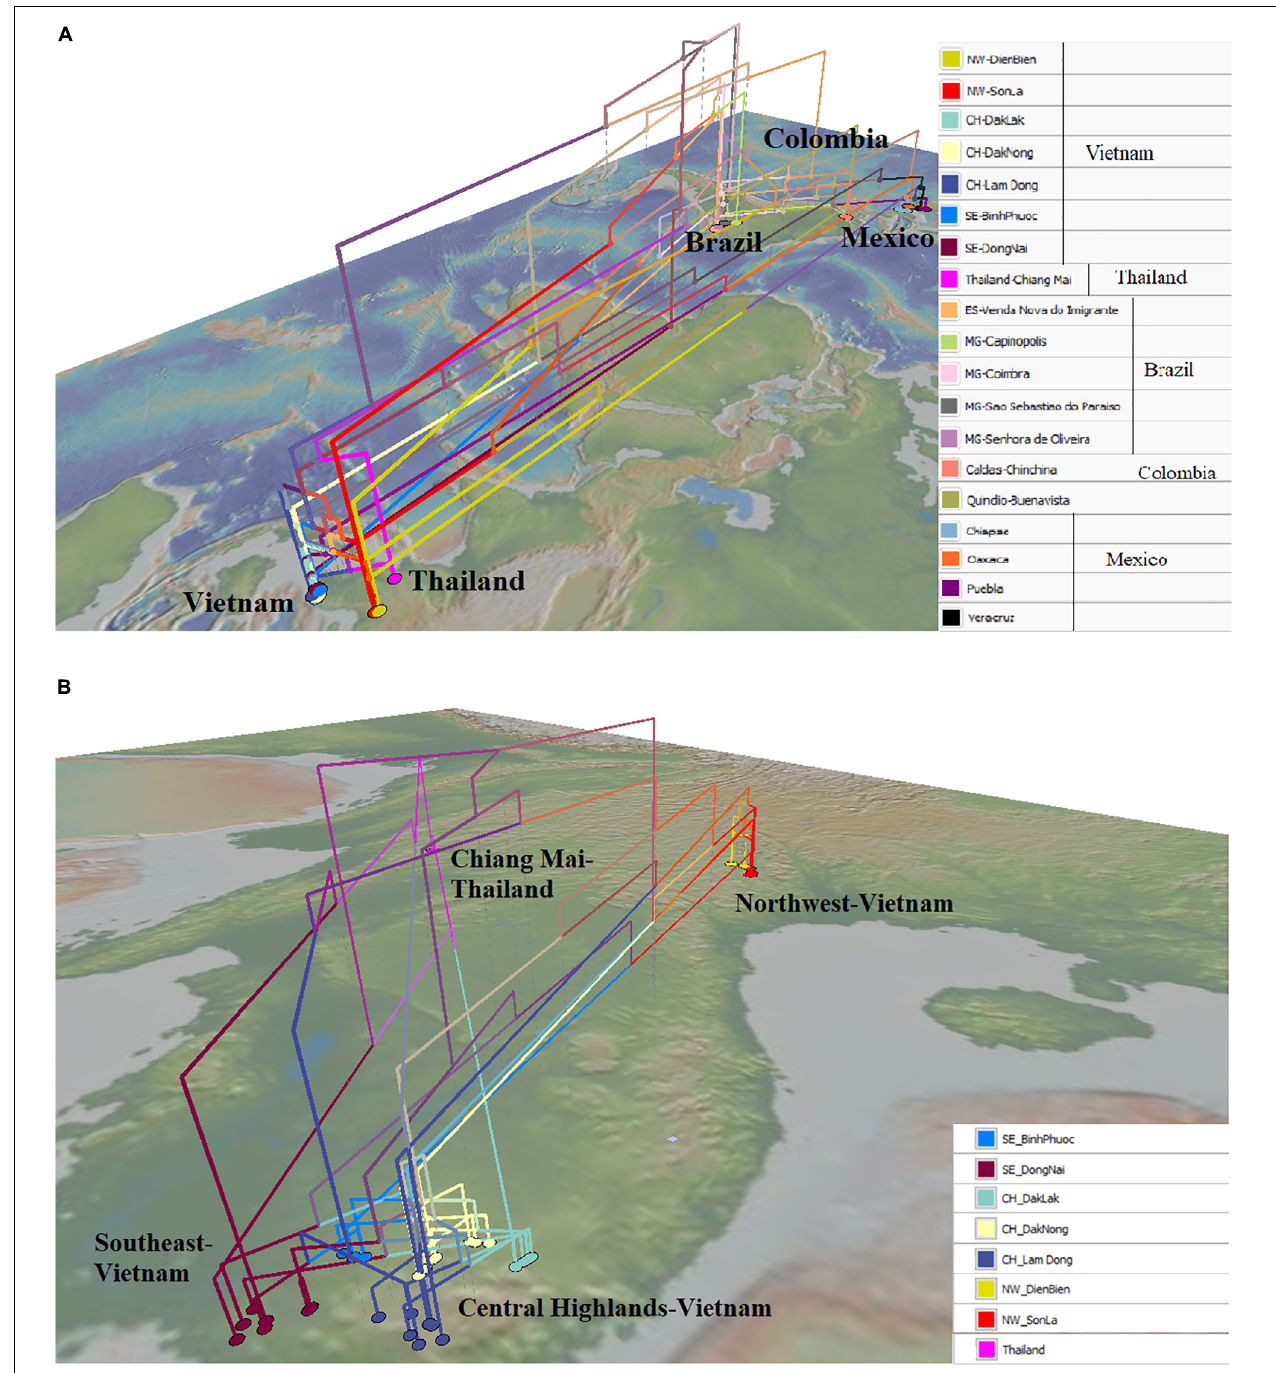
FIGURE 5 | Geophylogeny of Hemileia vastatrix from Vietnam, Thailand, and other American countries (Brazil, Colombia, Mexico) using ITS sequences. Colored nodes on the map correspond to sampling locations. (A) Geophylogeny of Hemileia vastatrix from Vietnam, Thailand, and Central and South American countries, (B) Geophylogeny of Hemileia vastatrix from areas in Vietnam and Chiang Mai-Thailand. NW: Northwest (Vietnam), CH: Central Highands (Vietnam), ST: Southeast (Vietnam), CIFC: Centro de Investigação de Ferrugens do Cafeeiro (Portugal), MG: Minas Gerais (Brazil), ES: Espírito Santo (Brazil).